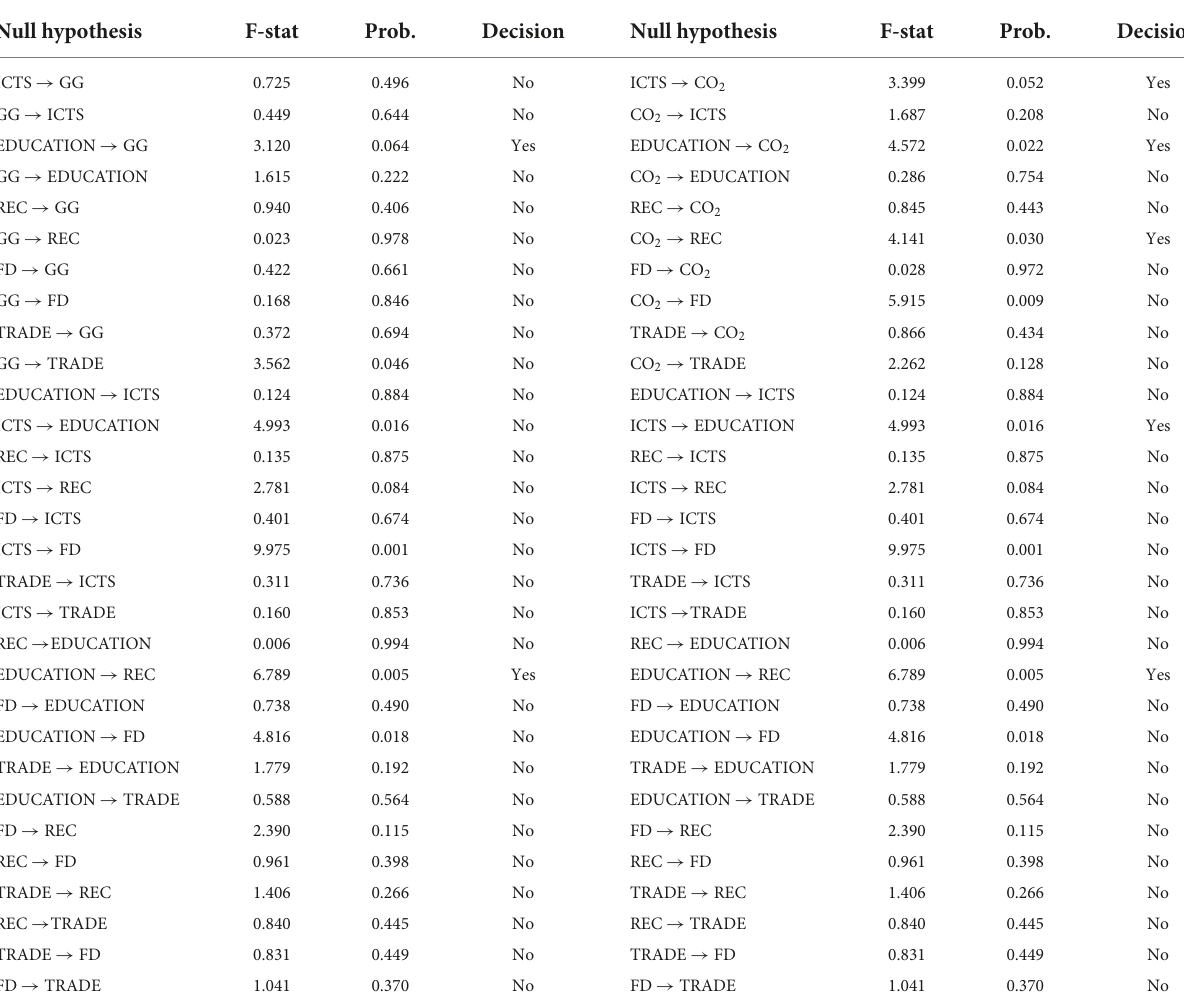
TABLE 4 Results of causality tests in